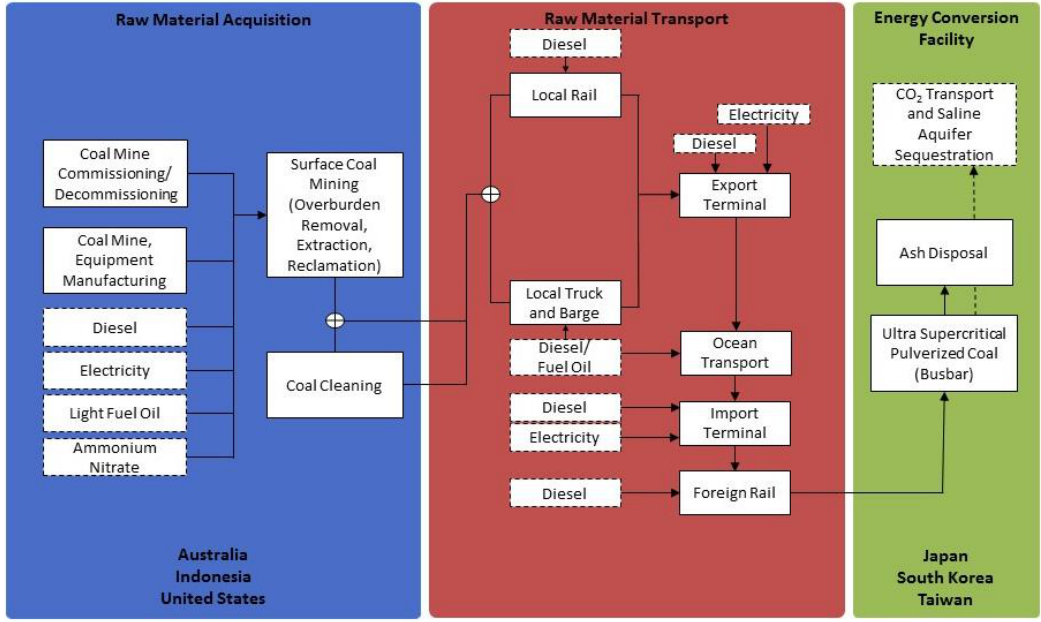
Figure 1. Coal Export LCA Process Diagram (Boxes and arrows with dotted lines represent potential or optional upstream or downstream flows in the model).